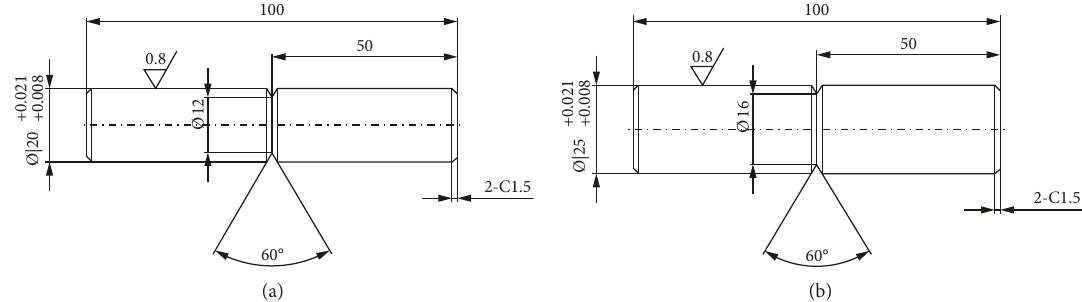
Figure 8: Configuration of pintles. (a) Outer diameter of 20mm and shear diameter of 12mm. (b) Outer diameter of 25 mm and shear diameter of